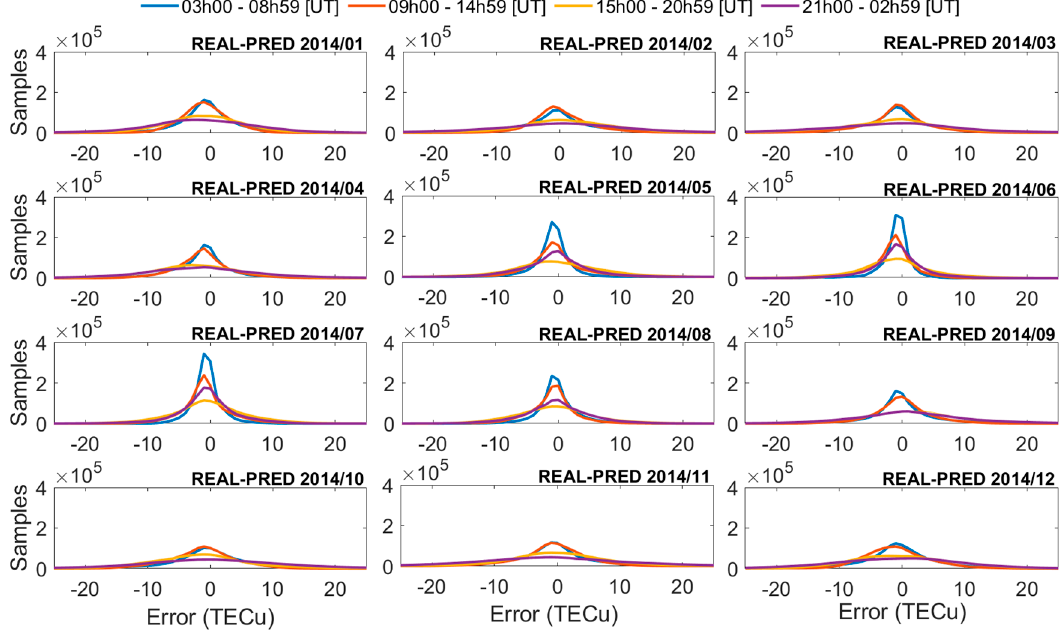
Figure 4. TEC errors according to month (panels) and time interval (colors) for the year 2014. The MLP-NN-based model presents good agreement with the data, especially during the winter solstice, as